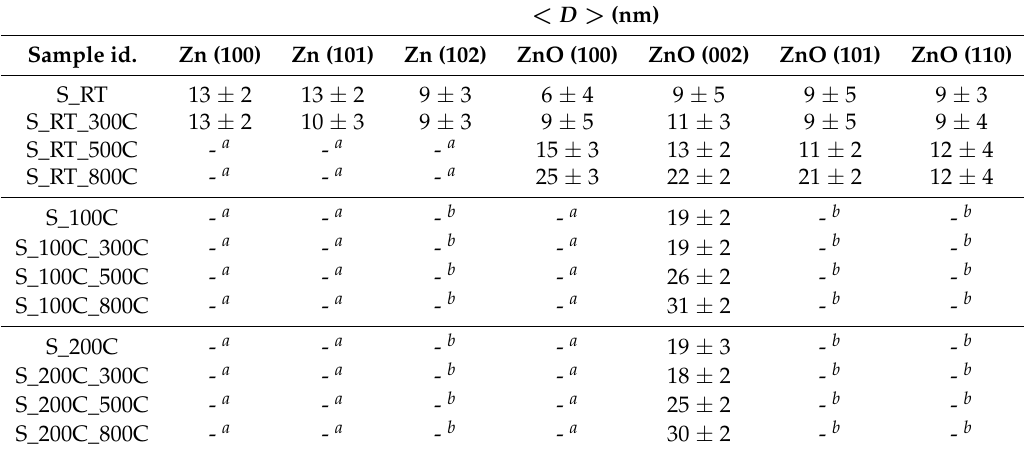
a not detected; b negligible